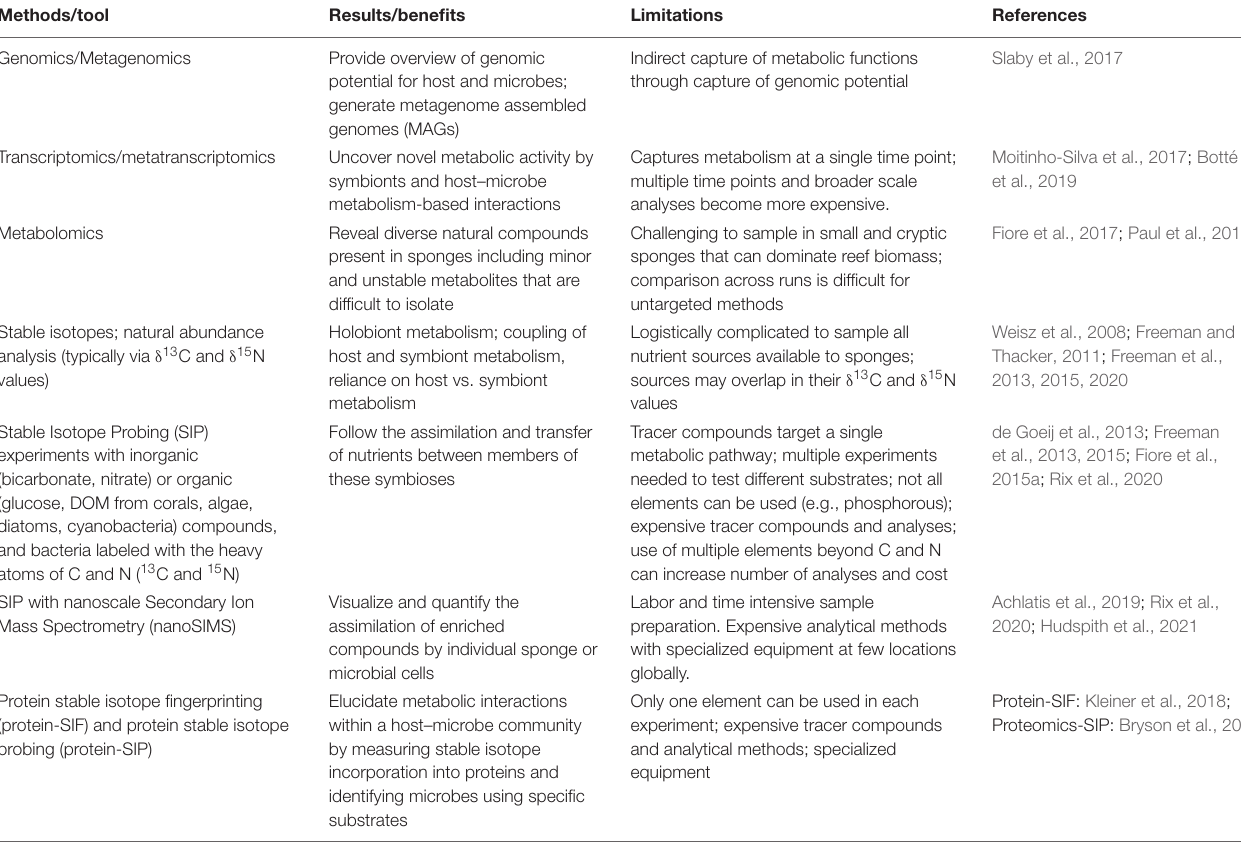
TABLE 3 | Emerging techniques to assess sponge and symbiont